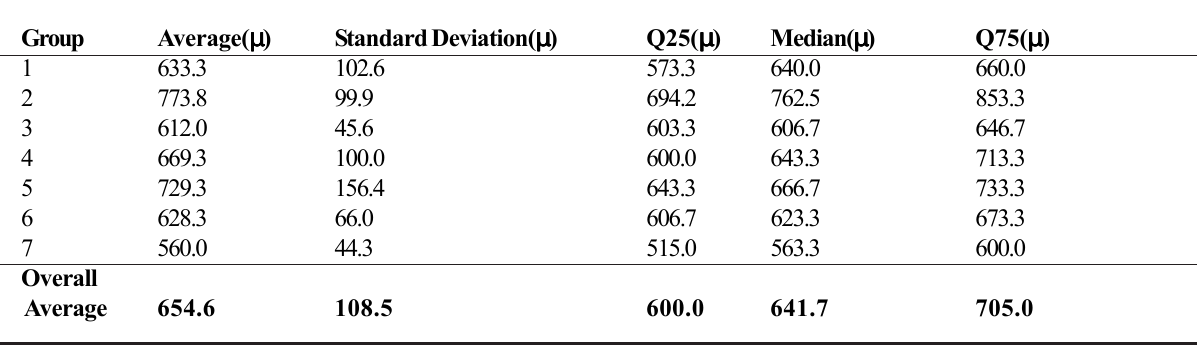
TABLE 1 — Measures of the upper edge thickness, with arithmetical average, standard deviation, Q25, median, Q75 of all groups, individually and